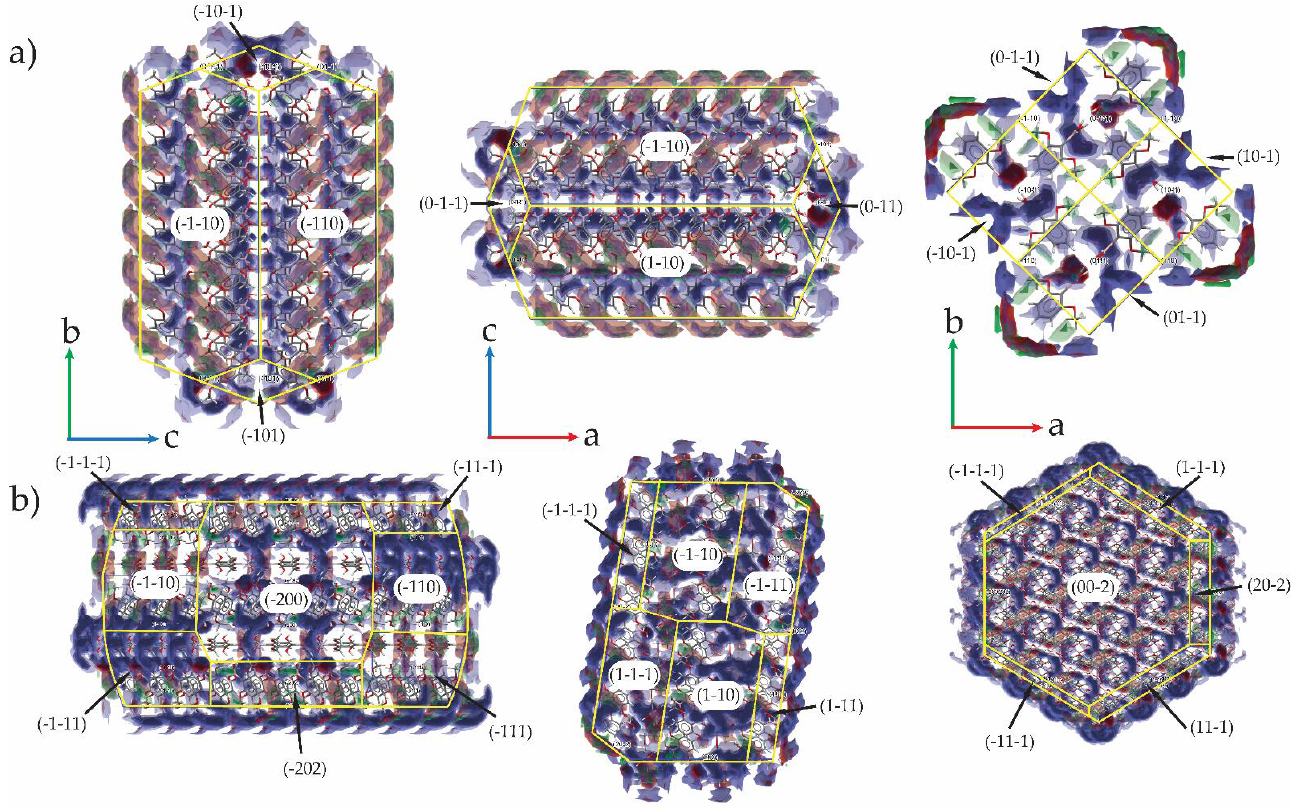
Figure 10. FIMs combined on the BFDH morphology of MPBA Form I ( a ) and Form II ( b ). Regions of hydrogen bond donor probability are shown in blue, hydrogen bond acceptors are shown in red, and hydrophobic interactions are shown in green.